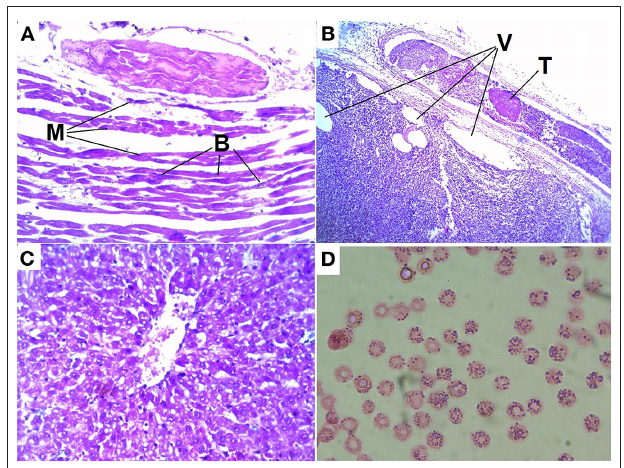
FIGURE 4 | Histologic lesions of blackleg in cattle: (A) destruction, hypereosinophilia, loss of cross-striations, contraction bands and fragmentation of myocytes (M) of the heart and accumulations of bacteria (B); (B) thromb in vessel (T) and vacuolization (V) in tissue of the adrenal gland; (C) degenerative changes and vacuolization of hepatocytes; (D) basophilic granularity in cow red blood